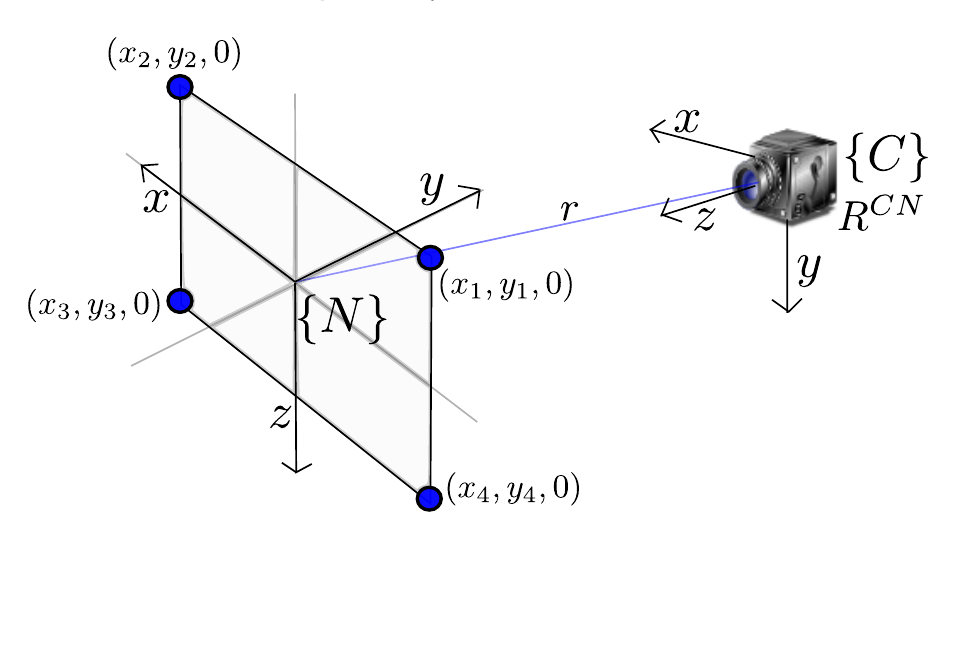
Figure 2. System